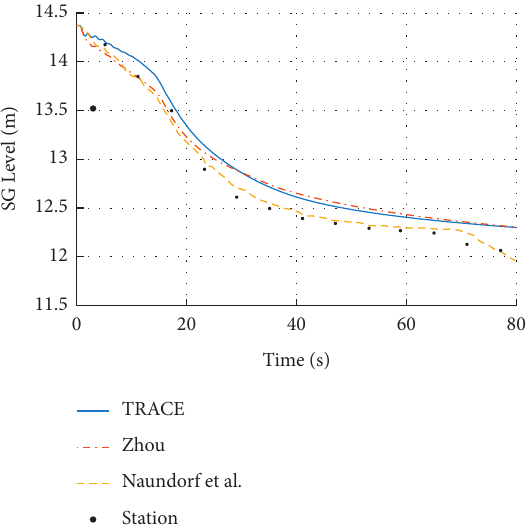
Figure 34: Steam generator levels for the loss of flow event.